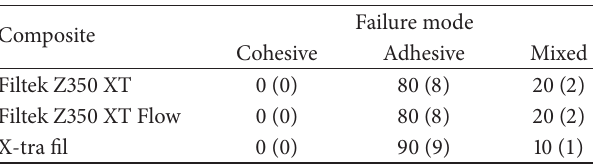
Table 3: Percentage (%) of failure